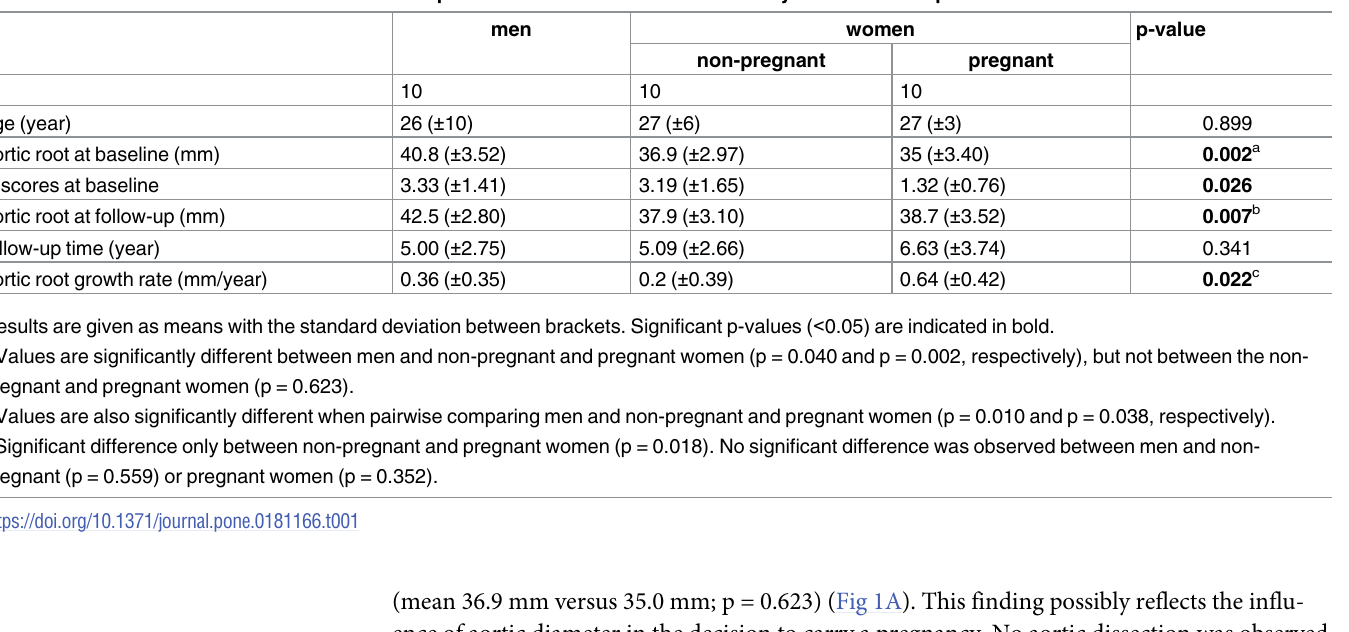
Table 1. Characteristics of the aortic root of MFS patients at baseline and after severalyears of follow-up.